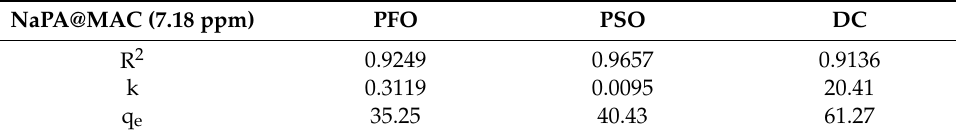
Figure 9. A 24h experiment for the kinetic behavior of Cr(VI) removal via adsorption on ( a ) NaPA@MAC and ( b ) NaPA@C, at pH = 3, T = 23 °C and for C init = 7.18 ppm Cr(VI). Best fit of three kinetic models on adsorption process experimental data for the case ( a ). Table 4. R 2, correlation coefficient values, k specific reaction rate values, and q e adsorbed amount at the equilibrium stage, which are provided by Levenberg–Marquardt Least-Square fitting algorithm upon the NaPA@MAC kinetic experimental dataset.